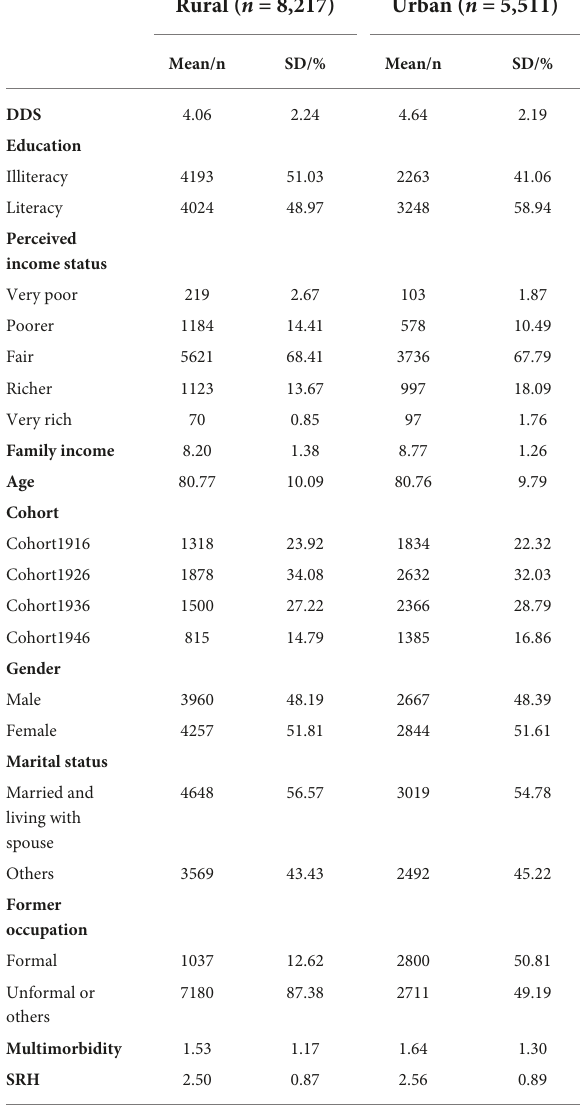
TABLE 2 Baseline information of dietary diversity score (DDS), sociodemographic factors, and